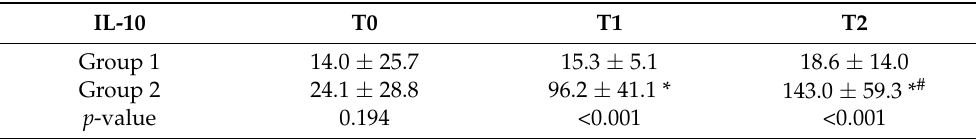
<0.001 <0.001 After receiving PCV-13 immunization (T2), we found a significant difference between the IL-8 levels in serum from the group supplemented with Vivomixx ® and the placebo group ( p < 0.001). However, there were no variations in T2 with respect to T1 for either study group. Table 6. IL-10 modulation in HIV+ patients at T0 (basal levels); T1 (after four weeks of supplementa- tion), and T2 (after eight weeks of supplementation and four weeks post-immunization). Data are reported as mean ± SD. p -values derived from the contrasts’ analyses are shown in italics. * indicates the statistically significant difference with respect to the basal time. # indicates the statistically significant difference respect to the previous observation